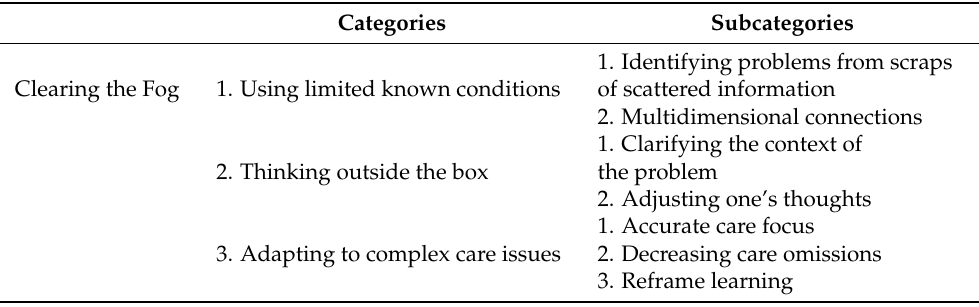
Table 2. Categories and subcategories of the